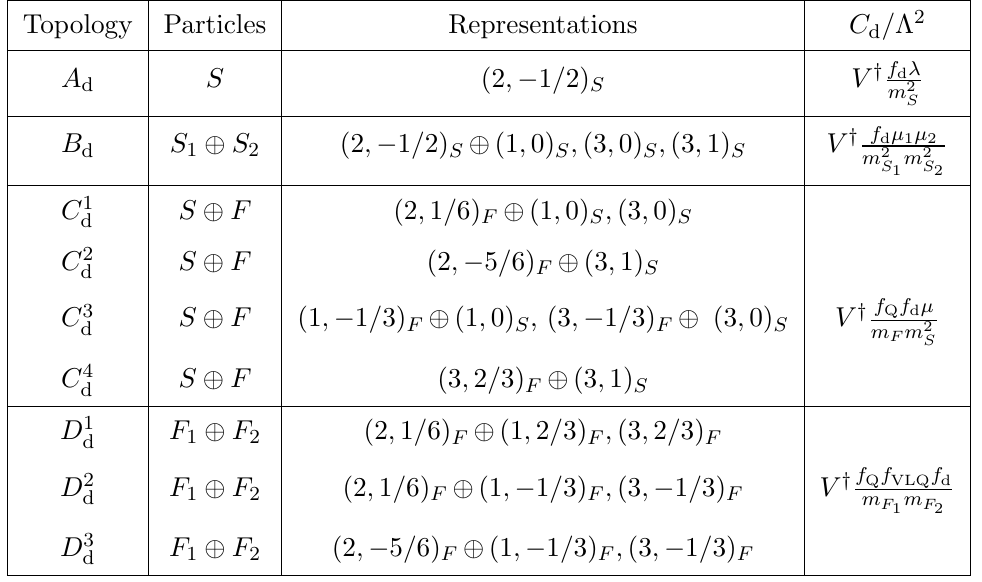
Table 2 . Similar to table 1 for the Yukawa operator of down-type quarks, see eq. (2.6).